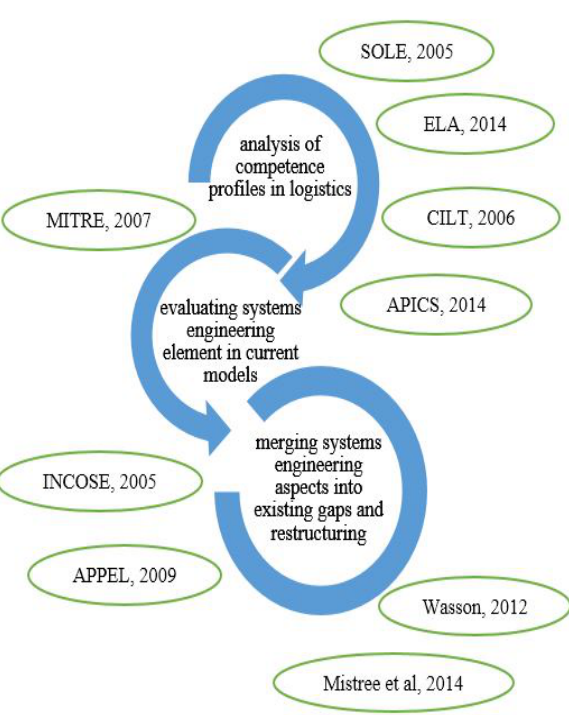
Figure 1. Applied methodology and main inputs in new model